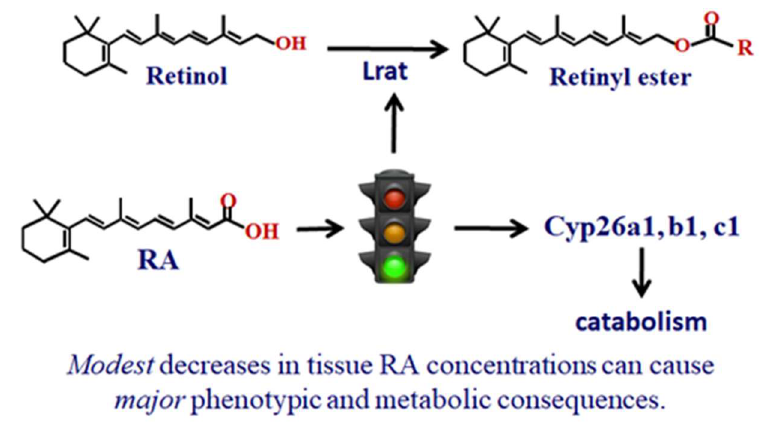
Figure 2. RA regulates its concentrations by removing retinol into esters and inducing catabolic enzymes .